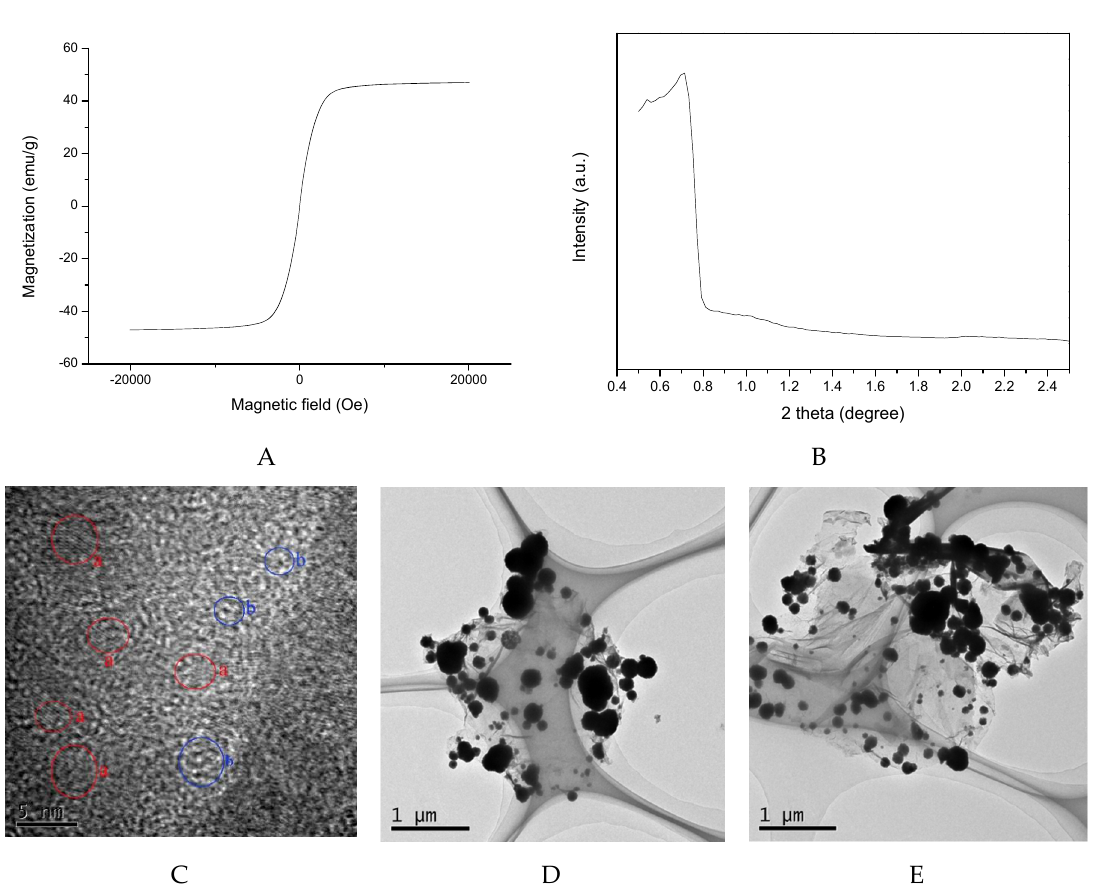
Figure 12. Magnetization curves of Mn-doped Fe/rGO ( A ), small angle X-ray diffraction (SAXRD) patterns of Mn-doped Fe/rGO ( B ), HR-TEM ( C – E ) images with different magnifications of Mn-doped Fe/rGO nanocomposites.